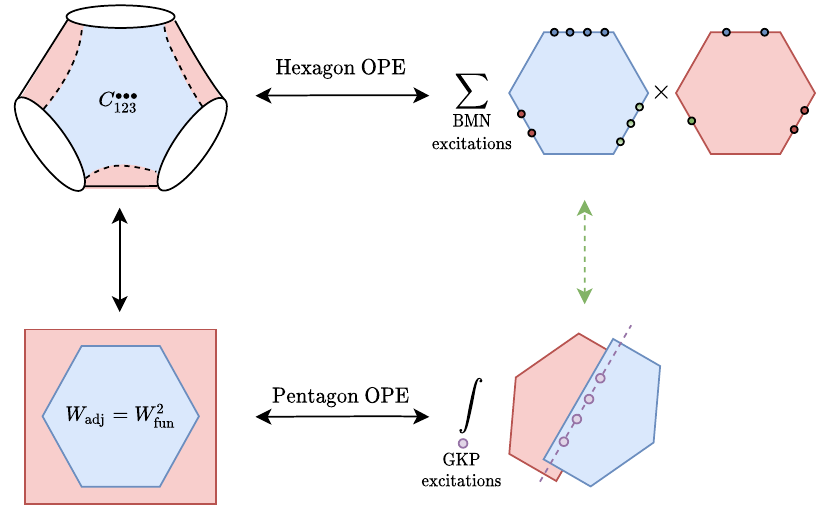
Figure 14 . Top arrow: this work, decomposition of the spinning three point functions into polarized hexagons. Left arrow: large spin three-point functions duality with null Wilson loops [3]. Bottom arrow: decomposition of null Wilson loops into integrable pentagons [23]. Right arrow: future work, how the integrable hexagons and integrable pentagons are related in the large spin limit.